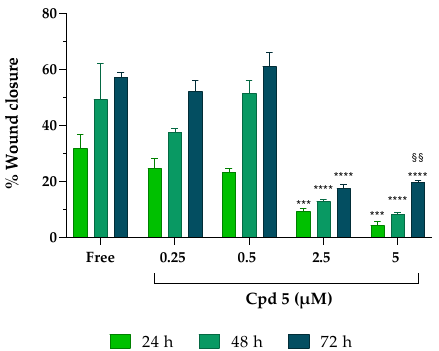
Figure 3. Effect of compound 5 on cancer cell migration. After scratching, LN229 cells were treated with increasing concentrations of compound 5 for 24–48–72 h. Results were obtained from n = 3 independent experiments run in triplicate; values are reported as the means ± SD. Two-way ANOVA followed by Tukey’s multiple comparison test was performed to determine statistical significance. 2.5 µM and 5 µM: *** p < 0.001, **** p < 0.0001 vs. free at the same timepoints; 5 µM at 72 h: §§ p < 0.01 vs. the same concentration at 24 h.